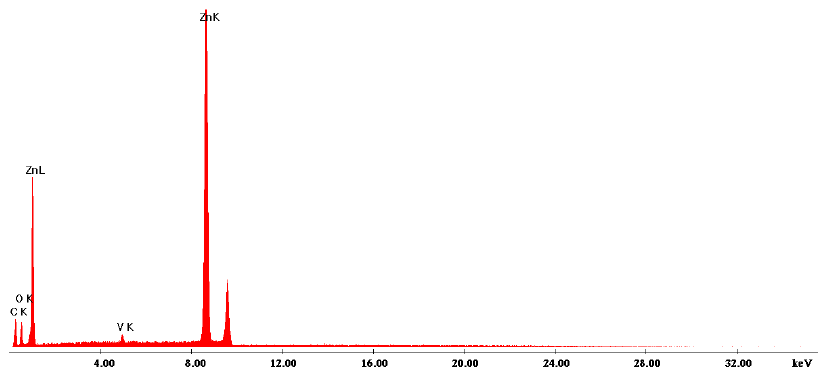
Figure 5. EDX spectra of the MW powders thermally treated at 650 °C/1 h.